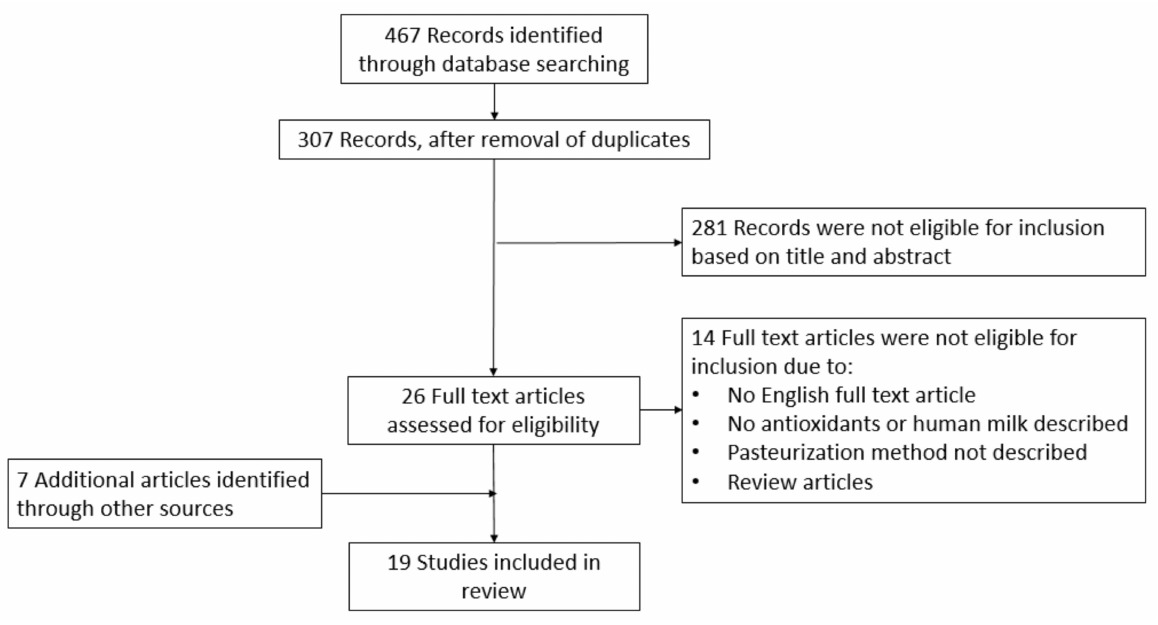
Figure 1. This flowchart presents the different phases of the review, according to the